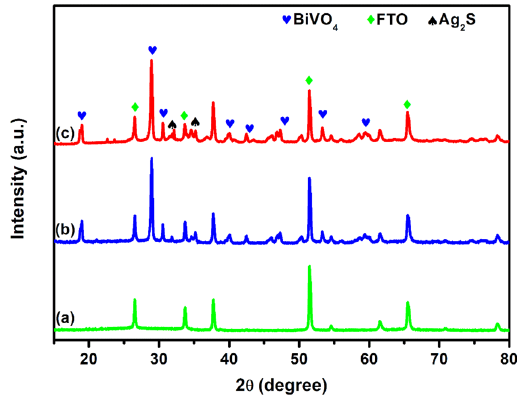
Figure 1. XRD patterns of ( a ) FTO, ( b ) FTO/BIVO 4 and FTO/BiVO 4 /Ag 2